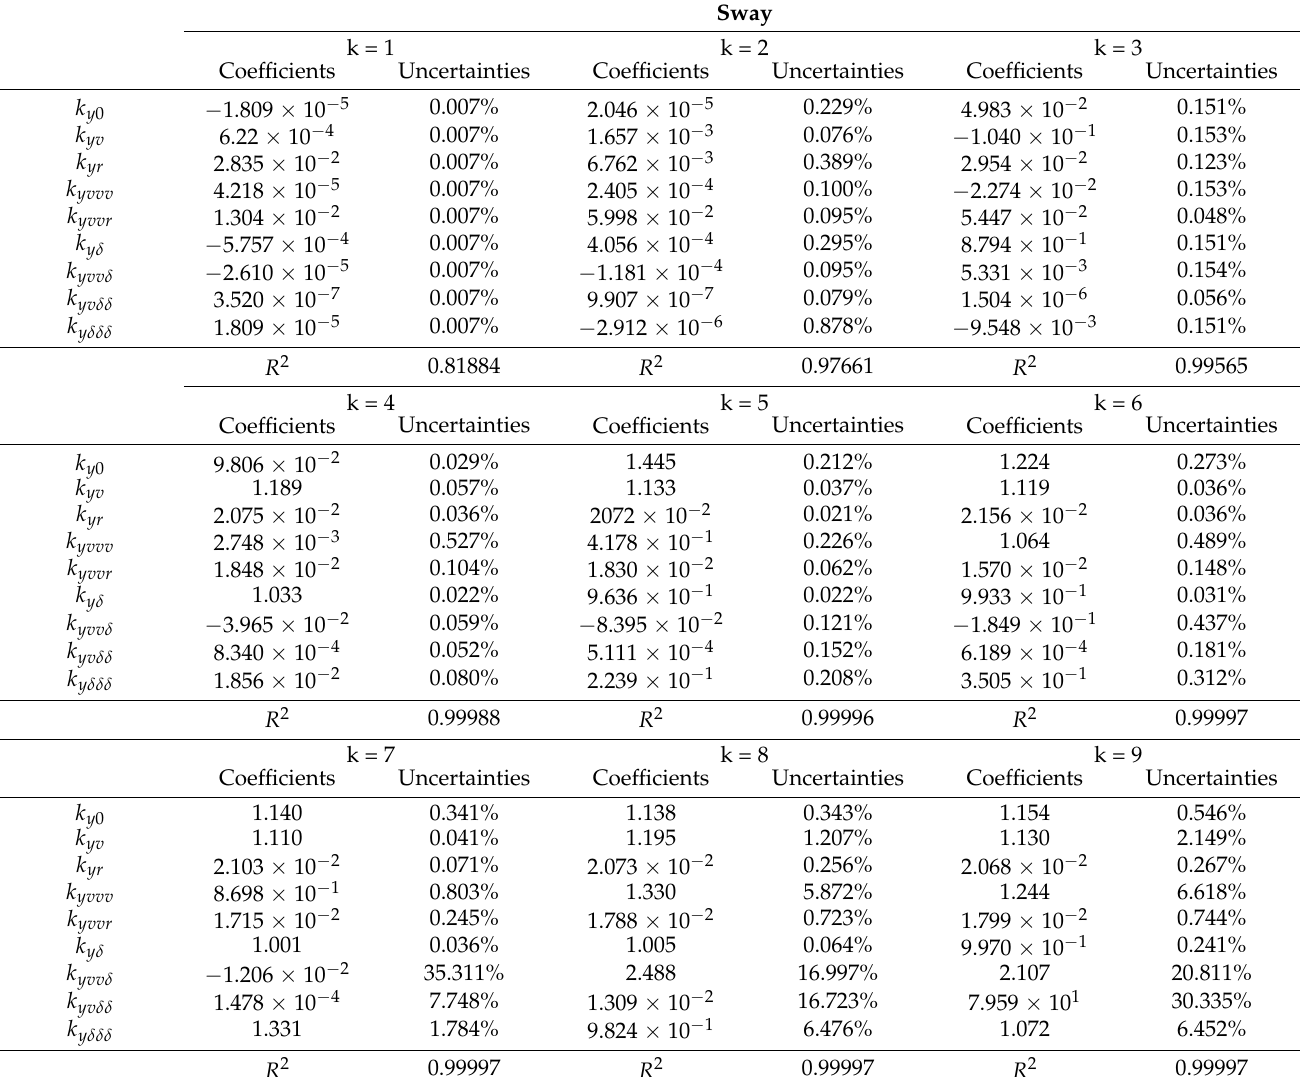
Table 3. Sway adjustment coefficients and uncertainties for simulation of 25 ◦ turning